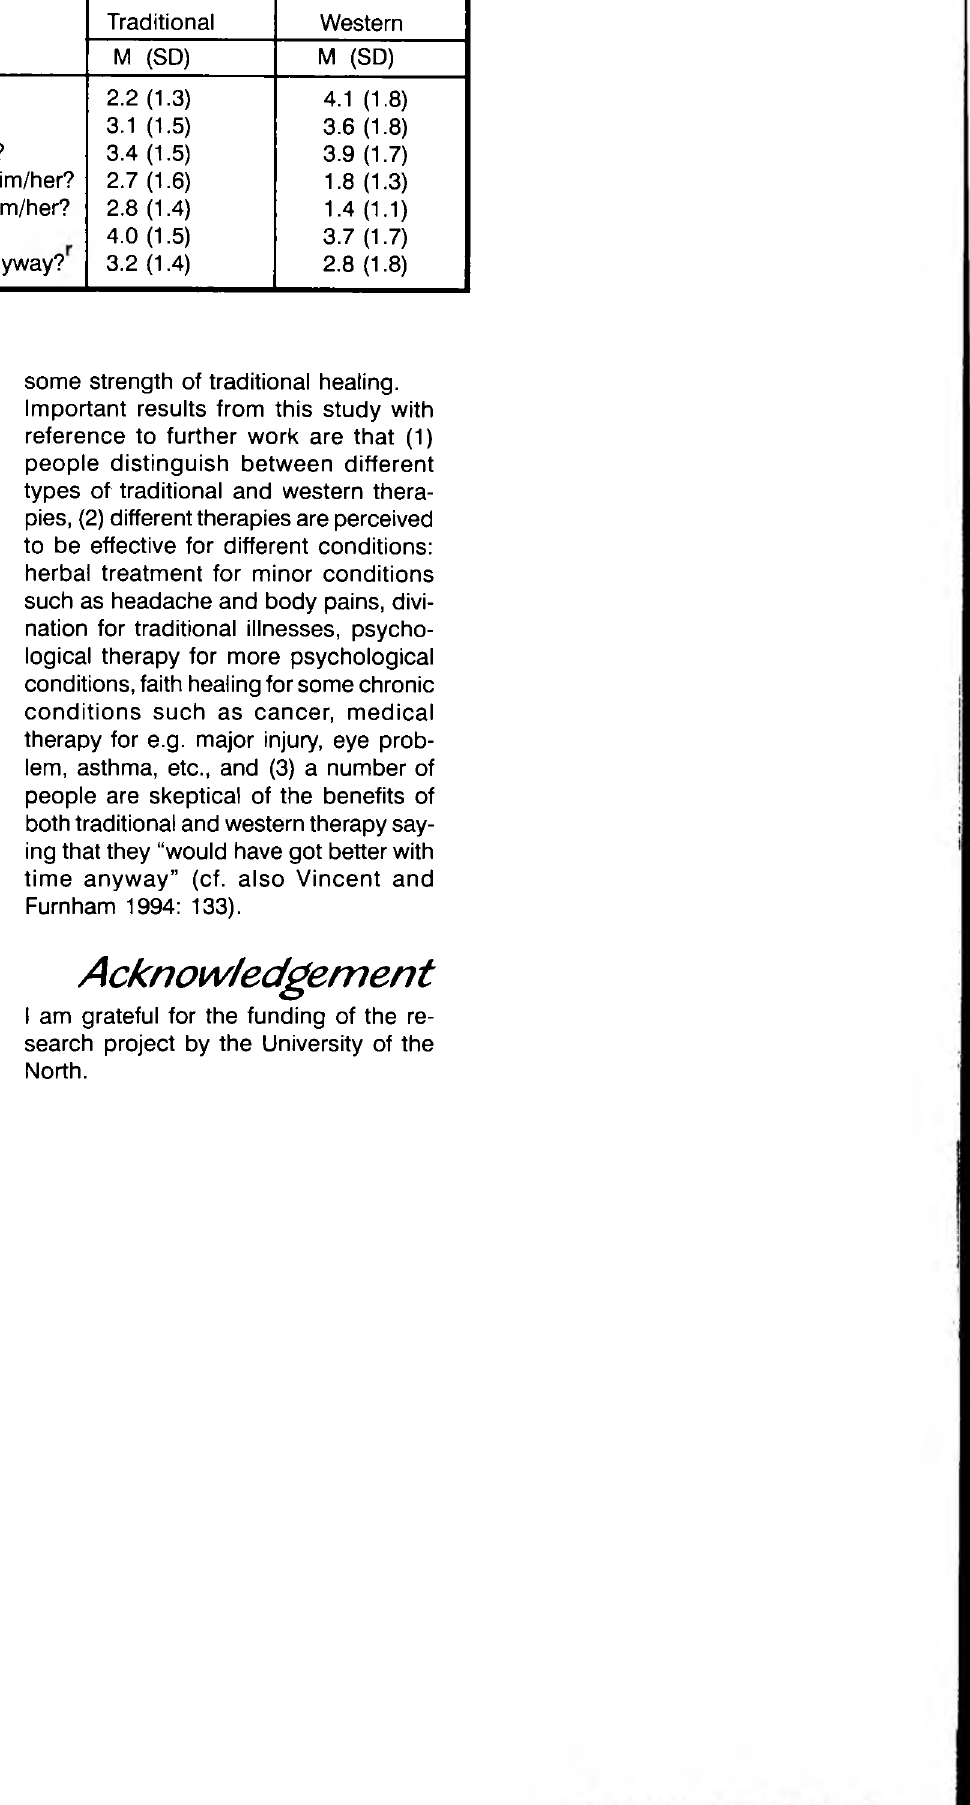
Table 2 : Mean scores from the self-reported efficacy (1= Not very effective/likely to 5= Very